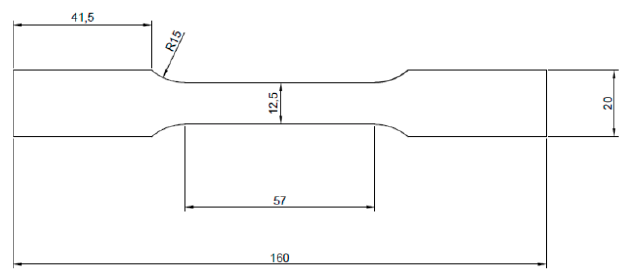
Figure 1. Scheme of sample for tensile testing. All dimensions are in mm. Thickness is equal to 5 mm.